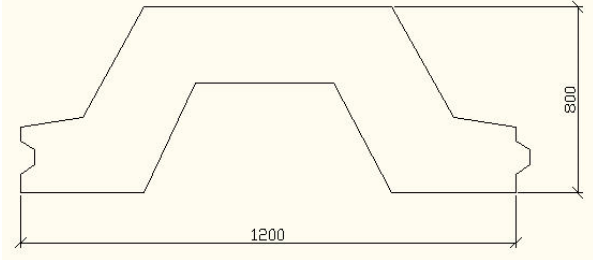
Figure 3. U-shaped sheet-pile engineering field profile. 2.2. GPR Data Acquisition and Processing The field data acquisition adopted the SIR-3000 GPR with a ground coupling system, shielded antenna with a central frequency of 400 MHz and 100 MHz, center control unit, and host computer (for data acquisition). The main testing equipment are shown in Figure 4, and the parameter settings for field data collection are shown in Table 1.